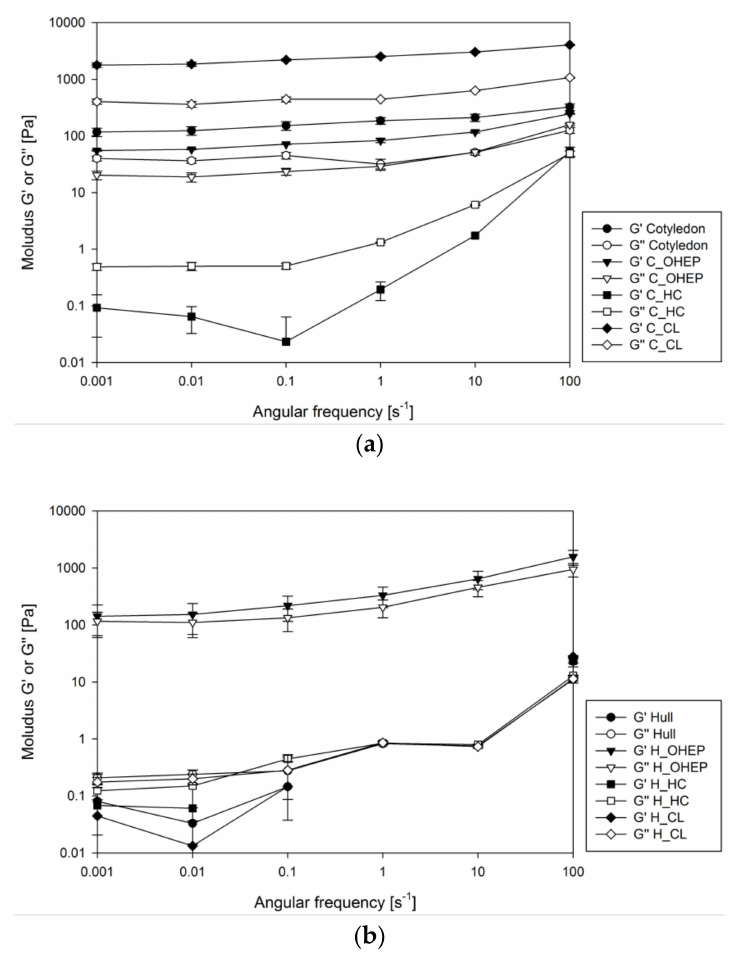
Figure 5. Frequency spectra of storage (G (cid:48) ) and loss (G”) moduli of in vitro digesta containing fractionated dietary fibre (pectin-like fraction (OHEP), hemicellulose fraction (HC), cellulose-lignin fraction (CL)) derived from lupin cotyledon ( a ) and hull ( b ) of L. angustifolius L. Boregine ( n =